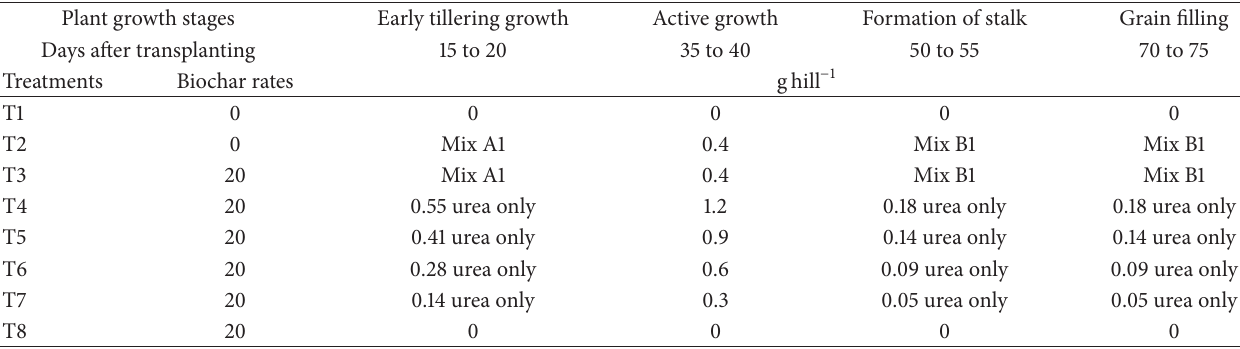
Table 3: Biochar rates and fertilization schedule of the pot